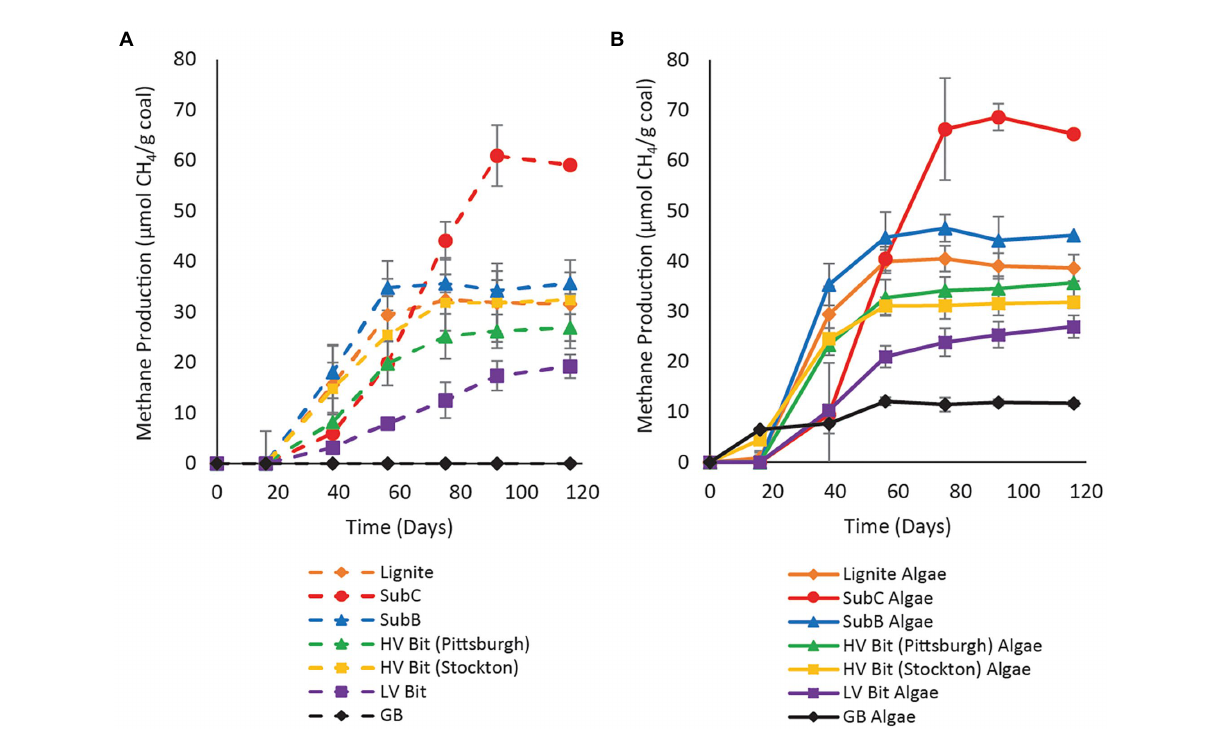
FIGURE 1 Methane production versus time for (A) unamended enrichment and (B) SLA-04 algae extract amended treatments. Algae extract was added to a final concentration of 0.1 g/l. Error bars represent one standard deviation of measurements from triplicate microcosms and are smaller than the markers where not